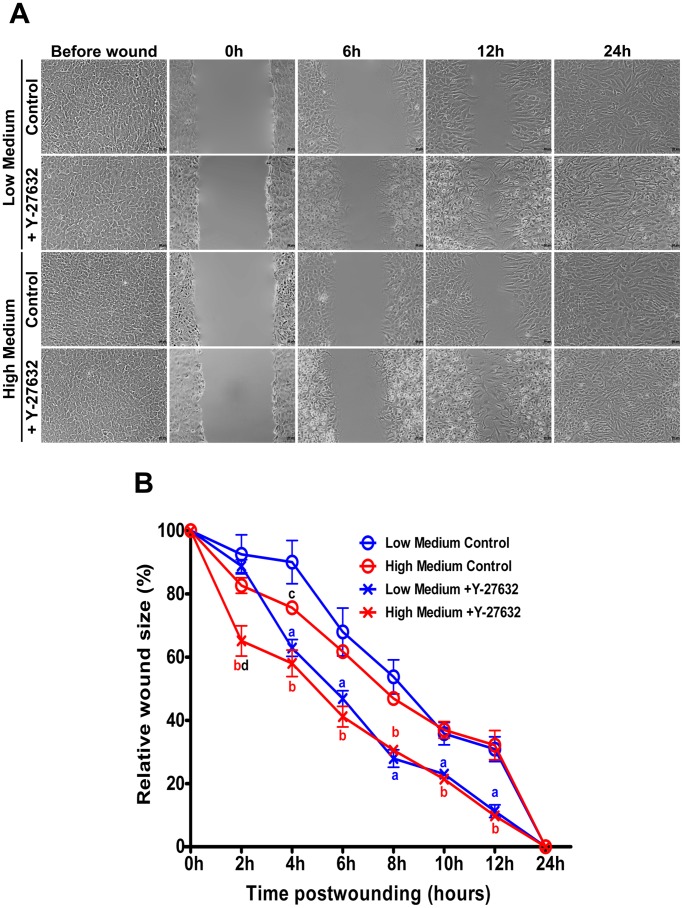

In vitro wound healing kinetic.(A) Representative micrographs of the wound healing kinetic. Wounds are totally closed whatever the conditions incubation after 24 hours. Compared to controls, Y-27632 enhances endothelial wound closure and cells adopt a fibroblastic-like appearance 6 hours after treatment. Magnification 10x. (B) Relative wound closure kinetic. Y-27632 significantly increases endothelial wound closure compared to controls (P = 0.0004). Globally no differences are observed between the Low and the High Medium in the wound healing process. a-d: P<0.05; a: Low Medium Control vs. Low Medium +Y-27632; b: High Medium Control vs. High Medium +Y-27632; c: Low Medium Control vs. High Medium Control; d: Low Medium +Y-27632 vs. High Medium +Y-27632 (2way Anova test; n = 9).